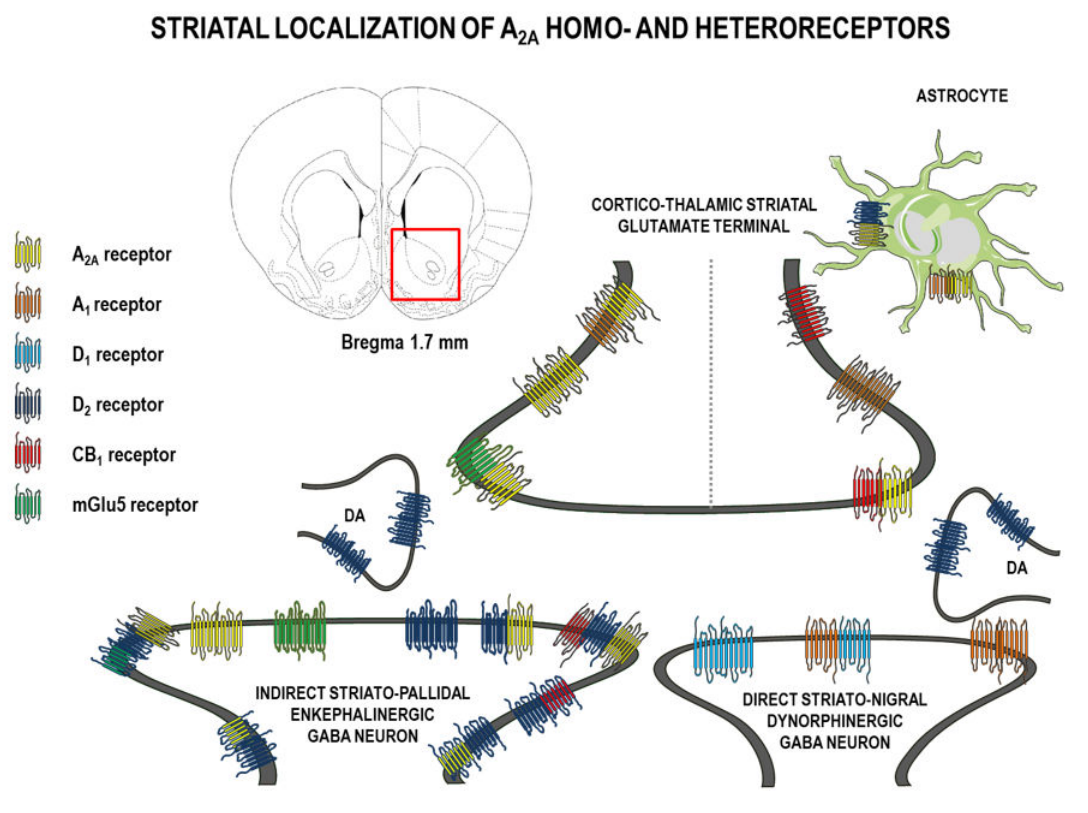
Figure 1. Schematic diagram showing the neuronal and astrocytic localization of adenosine (A)2A homo-, heterodimer, and oligomer complexes with dopamine (D), cannabinoid (CB), and metabotropic glutamatereceptors(mGlu)onglutamatergicinputfromthecortexandthalamusanddopaminergic(DA) input from the ventral tegmental area and both enkephalinstriato–pallidal and dynorfinstriato-nigral gamma-aminobutyric acid (GABA) neurons in the rat striatum. To simplify, cholinergic interneurons are not